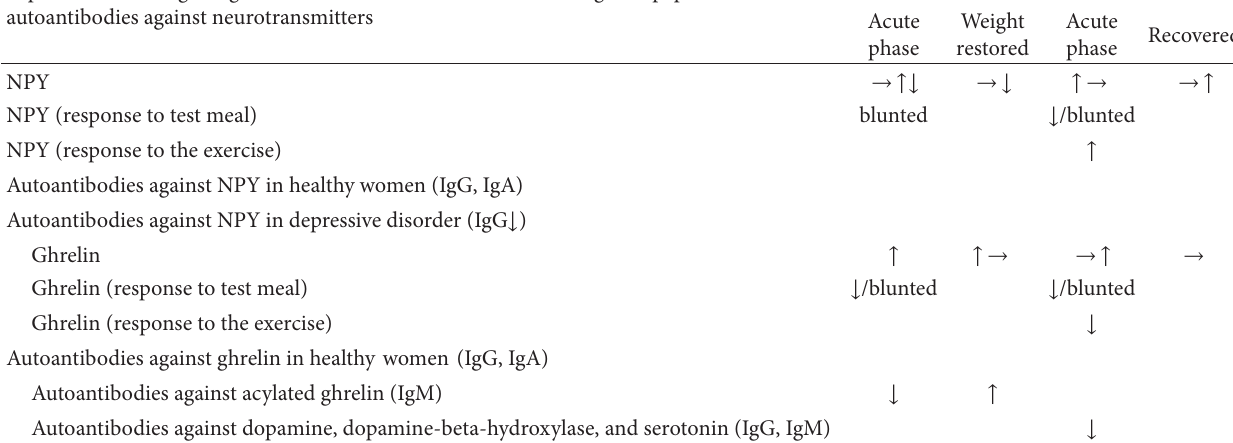
Table 2: Summary of the most relevant changes of adipose tissue-gut-brain axis plasma peptides inhibiting appetite in patients with anorexia nervosa (AN) and bulimia nervosa (BN), and the presence of autoantibodies against leptin and peptide YY (PYY) in healthy women. Cholecystokinin (CCK), immunoglobulin (Ig) G, and IgA classes. Peptides inhibiting hunger and food intake and